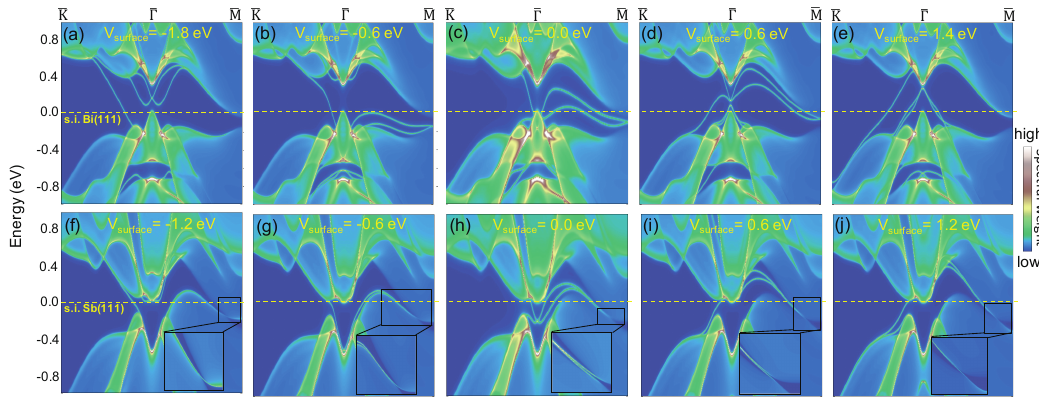
Figure 4. ( a – e ) Band spectrum of semi-infinite Bi under different surface potential bias. ( f – j ) Same as ( a – e ) but for